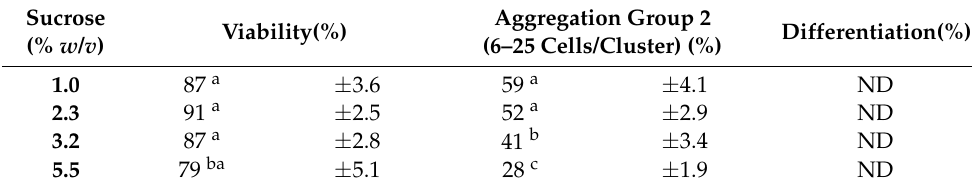
Table 4. Quality parameters (viability and aggregation) for T. officinale suspension cultures maintained at different sucrose concentrations after an 8-wk